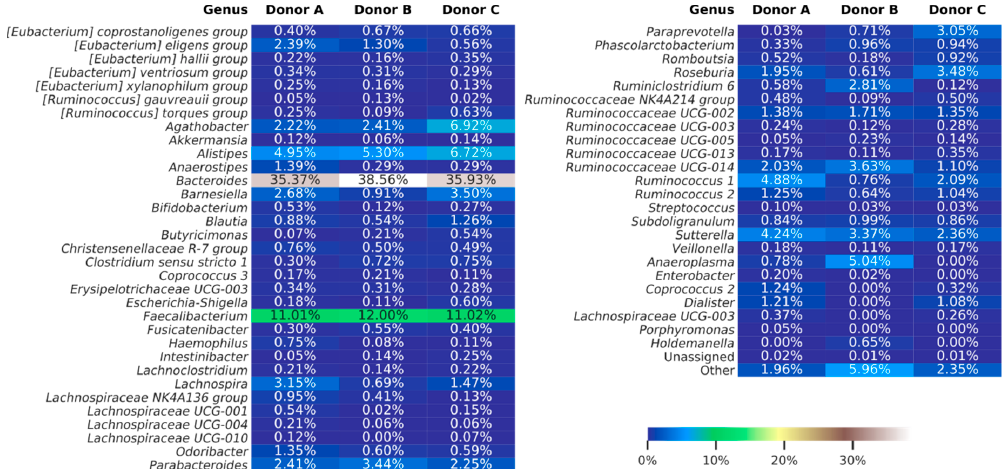
Figure 5. Heat map showing bacterial genera detected using amplicon sequencing (V3–V4 region of 16S rDNA). The summarized data for each donor are presented. The “others” group summarizes genera with individual abundances lower than 0.5% in any sample. Sequences unassigned at the genera taxonomy level were grouped and named “unassigned”.